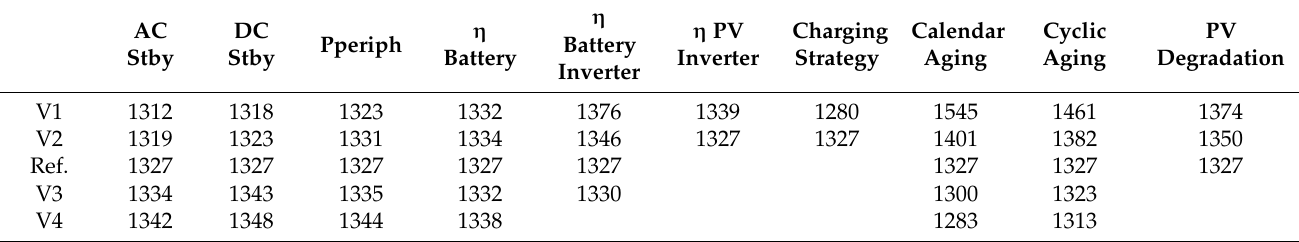
Table A4. Electricity costs per year in € depending on the change of different technical parameters. The selected PV system and battery combination is the combination that is the most favorable for the respective boundary conditions.